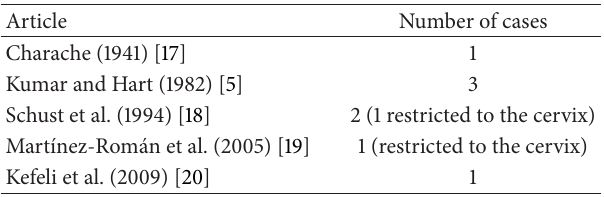
Table 3: Cases of gallbladder carcinoma metastasising to the